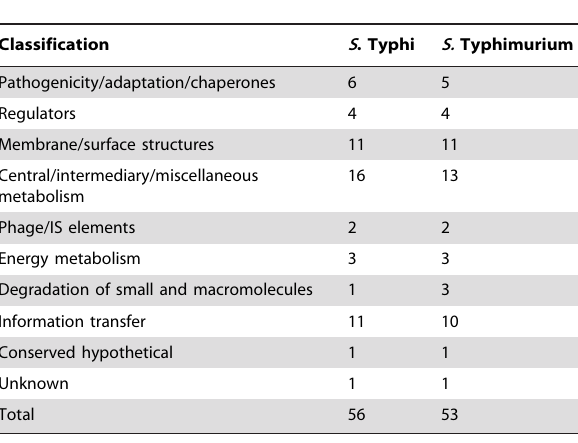
Table 1. Functional categories of detected PhoP-regulated